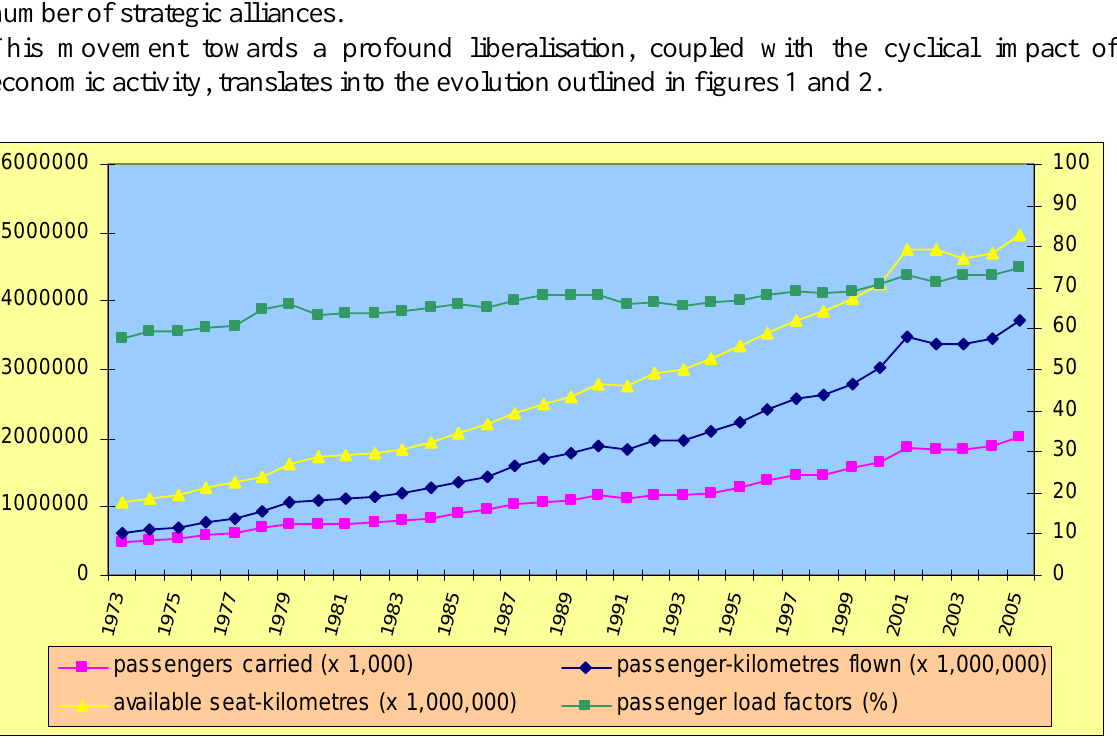
Figure 1. World air transport scheduled services (domestic + international) – passengers Source: